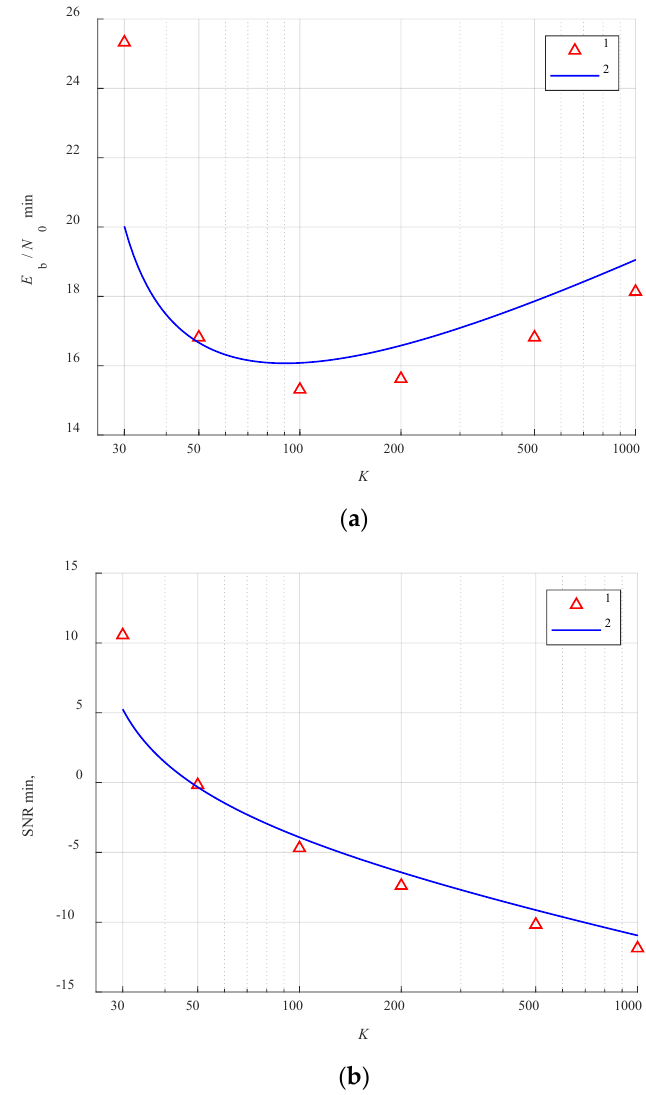
Figure 12. Plots of ( a ) E b / N 0 and ( b ) SNR as functions of the processing gain that provides p = 10 − 3 ; 1—computer simulation (Gaussian distribution) 2—analytical estimate.